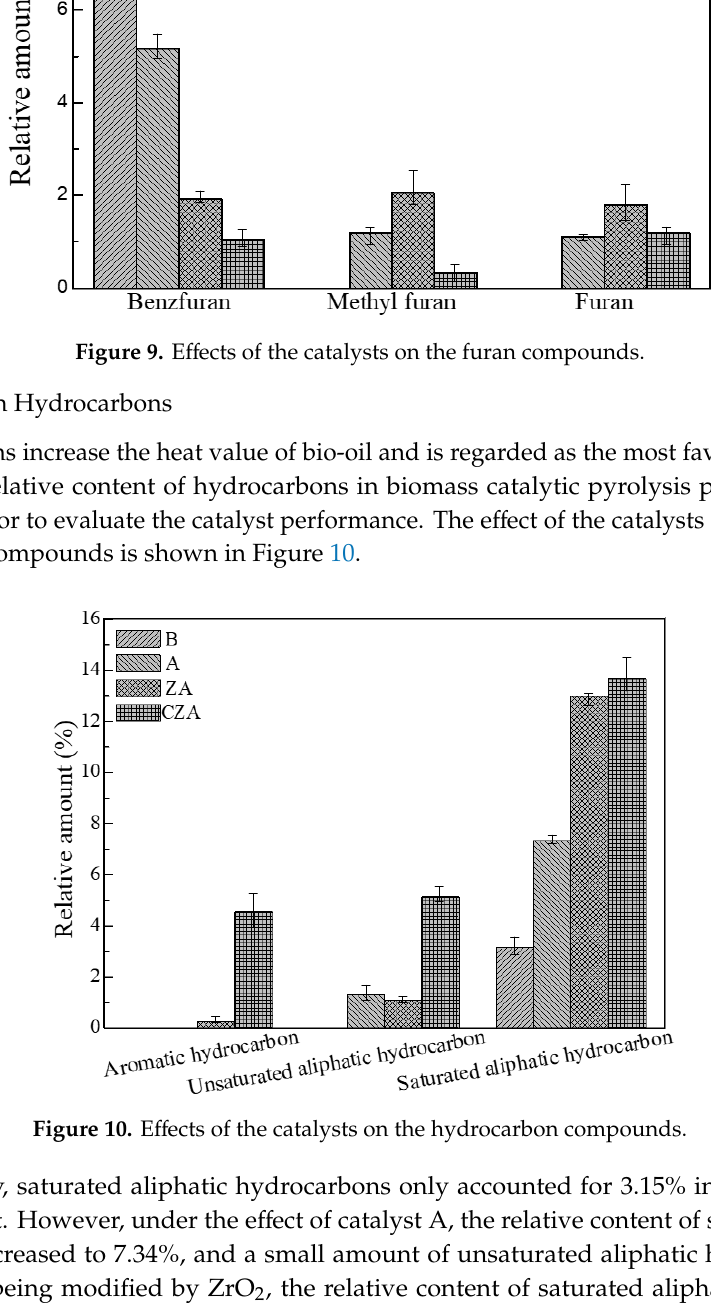
Figure 9. Effects of the catalysts on the furan compounds.